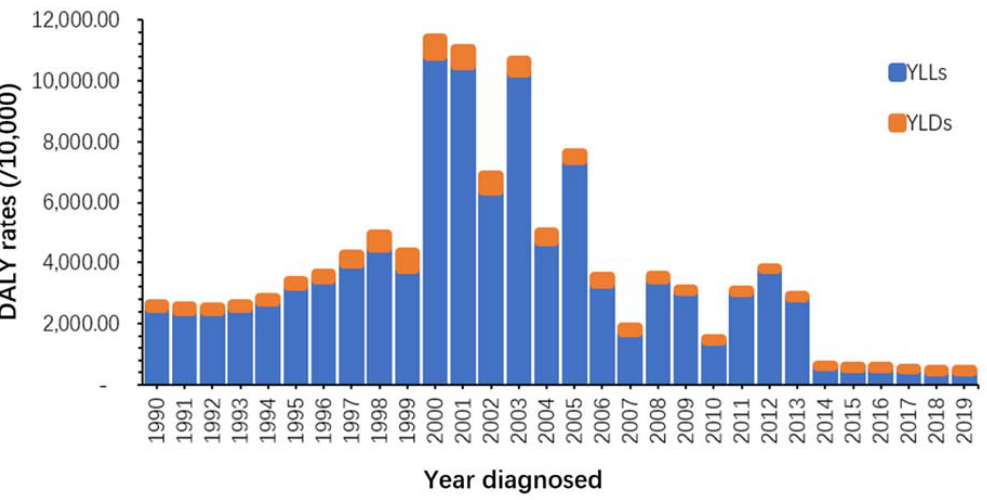
tinued to be a significant declining trend (APC = − 26.73%, t = − 8.06, p < 0.01). In the last stage, the downward trend slowed from 2010 to 2019 (APC = − 1.93%, t = − 6.21, p < 0.01) (Figure 5).